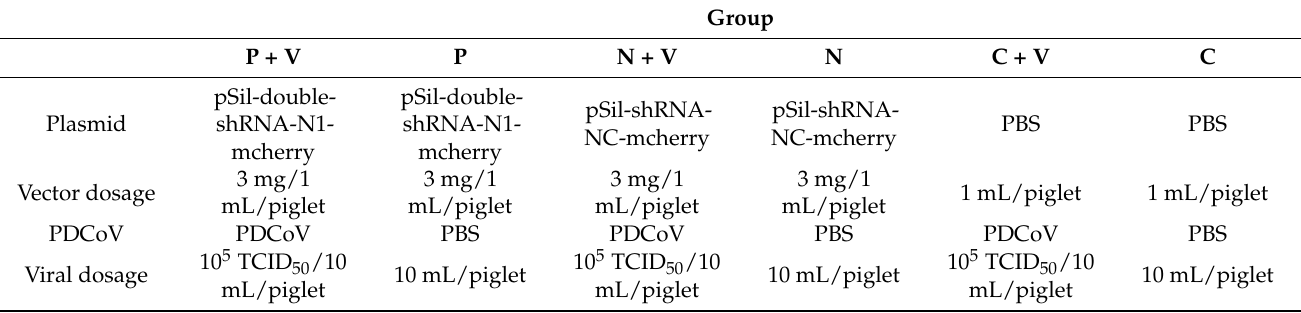
Table 3. Plasmids delivery and virus infection